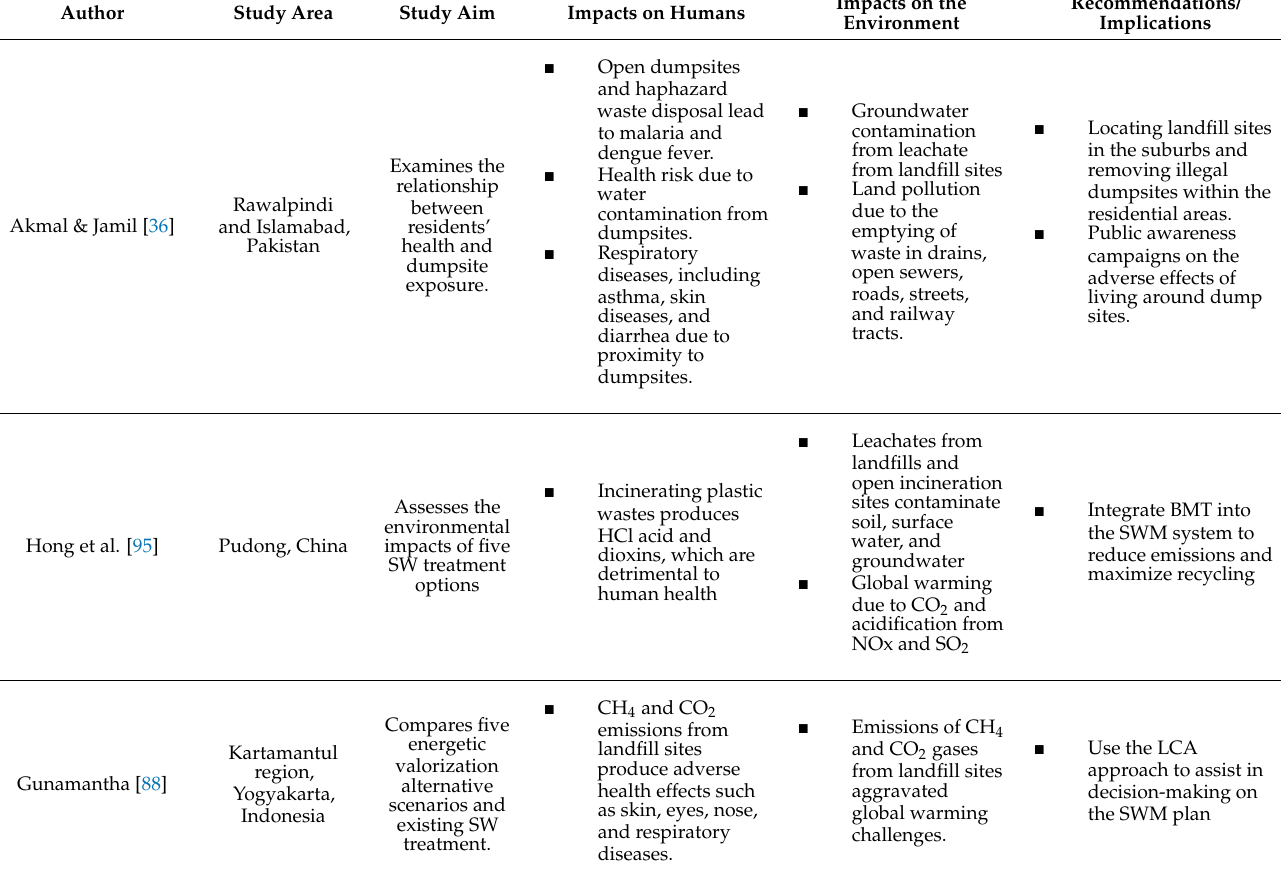
Table A1. Reviewed literature on the impacts of SWM practices in Asia (compiled by